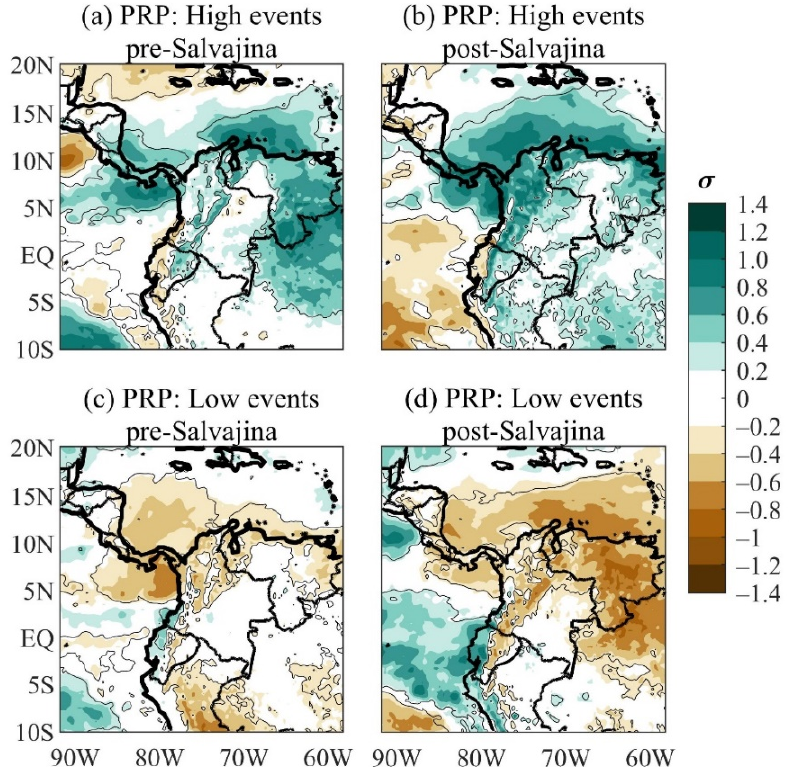
Figure 8. Standardized precipitation anomalies during ( a ) high discharge events pre-Salvajina; ( b ) high discharge events post-Salvajina; ( c ) low discharge events pre-Salvajina; and ( d ) low discharge events post-Salvajina. Shading interval: 0.2 SD. Continuous contours indicate significant values at the 95% confidence level.